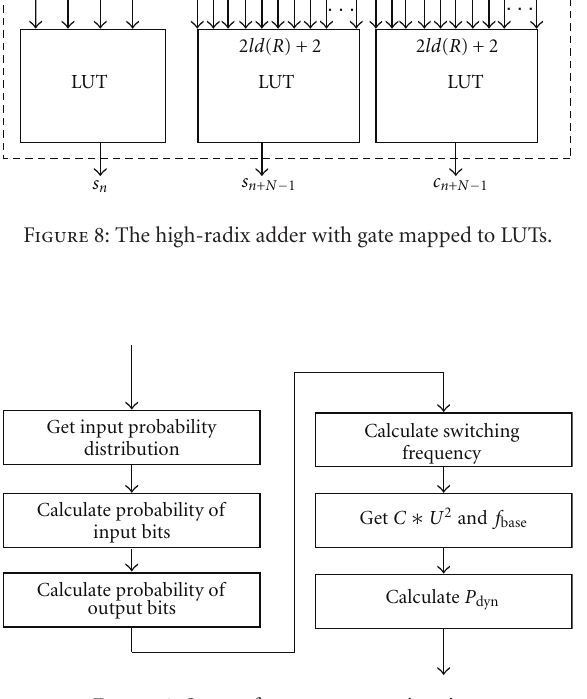
Figure 9: Setup of a new power